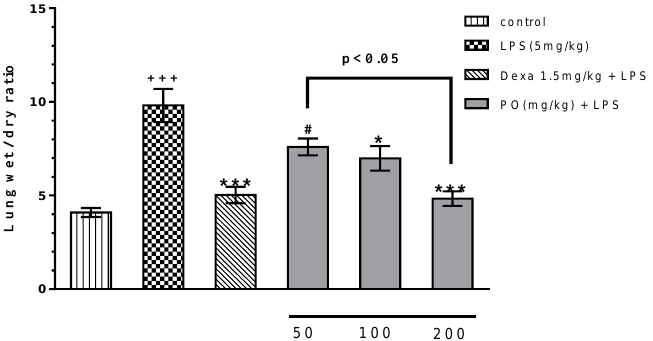
Figure 1. Effect of Portulaca oleracea (PO) extract on the lung wet/dry ratio in broncho alveolar lavage fluid (BALF). Data were presented as mean ± standard error of measurement (SEM) ( n = 6). +++ p ≤ 0.001 compared with the control group, * p ≤ 0.05 and *** p ≤ 0.001 compared with the lipopolysaccharide (LPS) group, and # p ≤ 0.05 compared with the Dexa + LPS